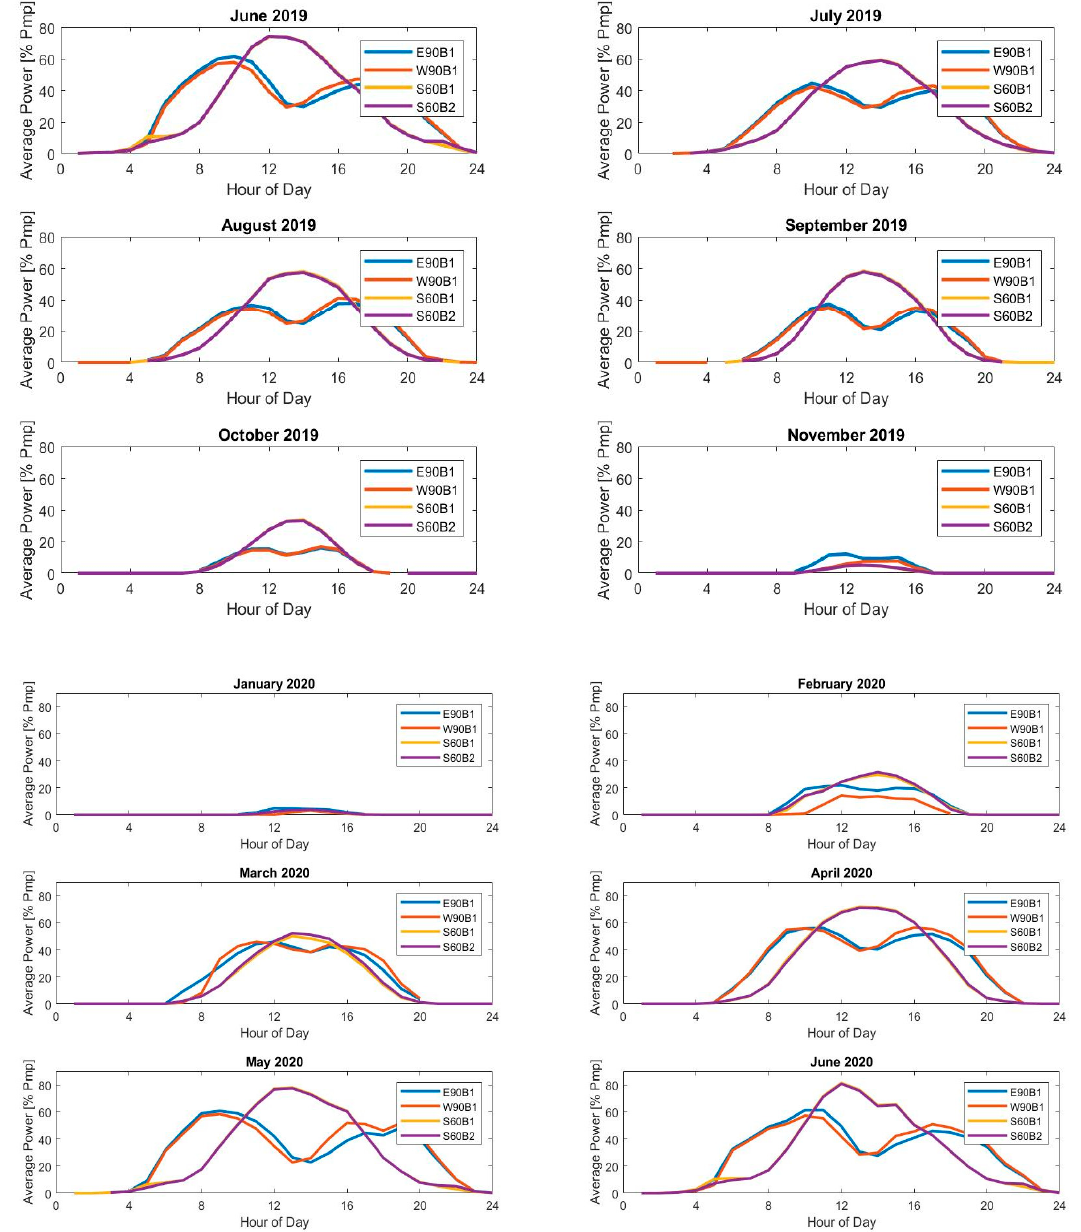
Figure 11. The average hourly production for south-facing bifacial PV modules and vertical east-west facing bifacial modules is shown for each month of the study period in Alaska Standard Time.